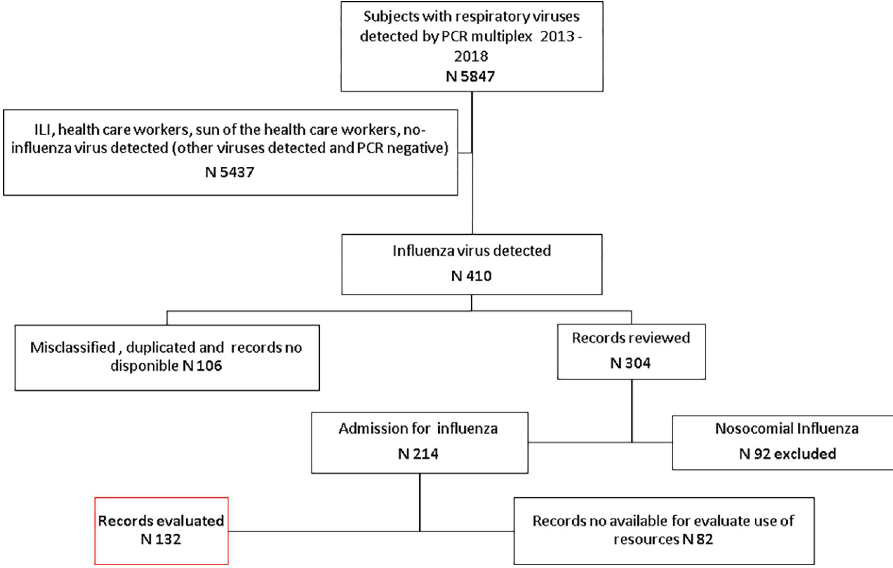
Fig 1. Diagram of selection of records to